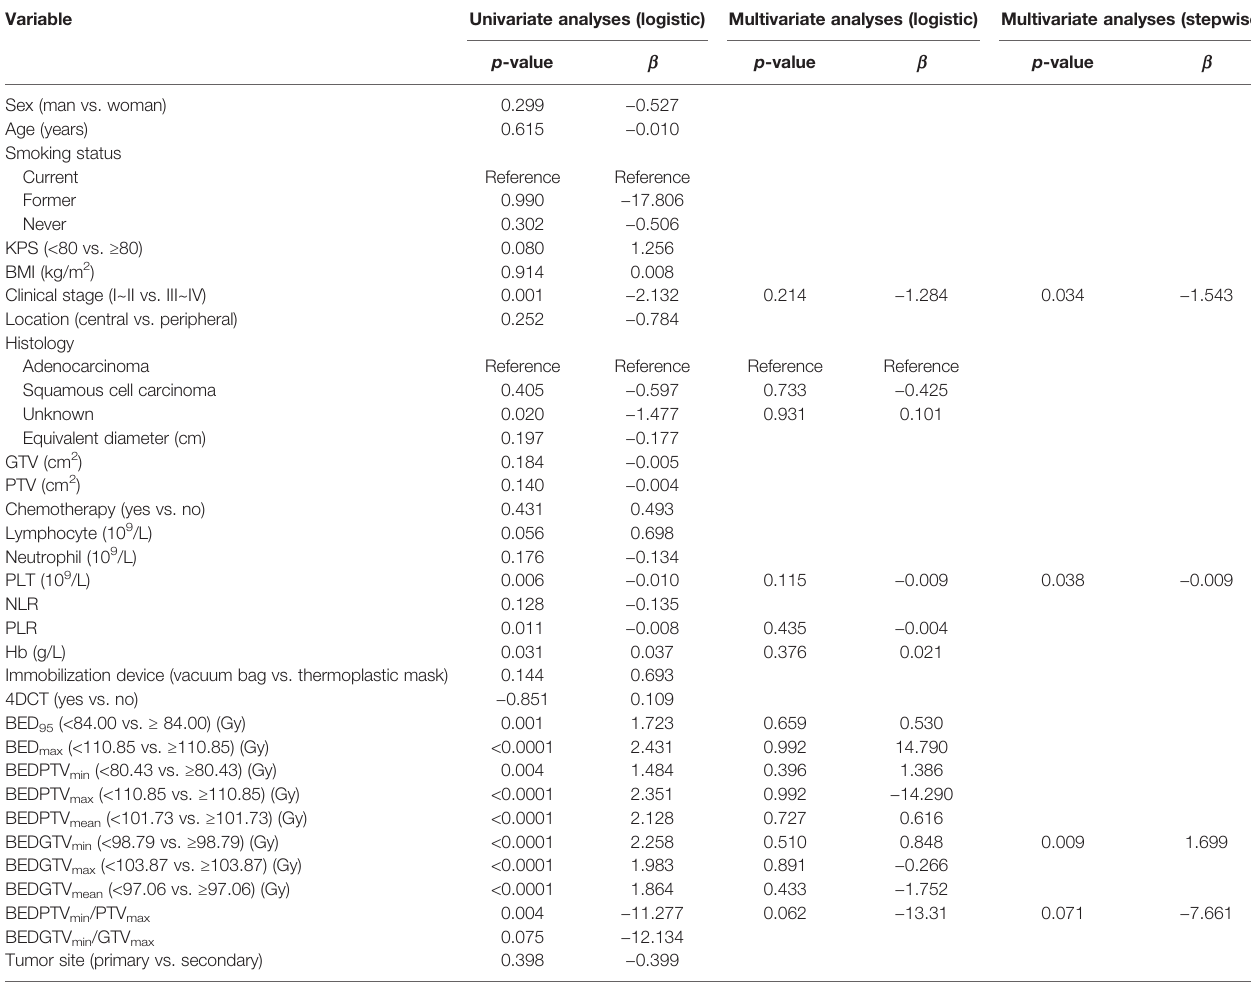
TABLE 2 | Univariate and multivariate analyses of clinical and dosimetric parameters.